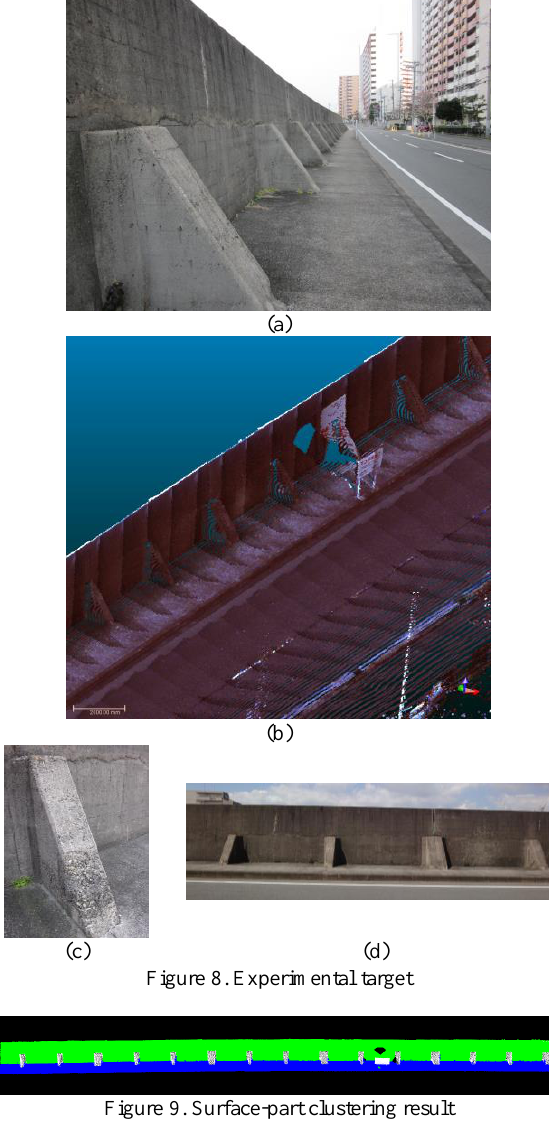
Figure 9. Surface-part clustering